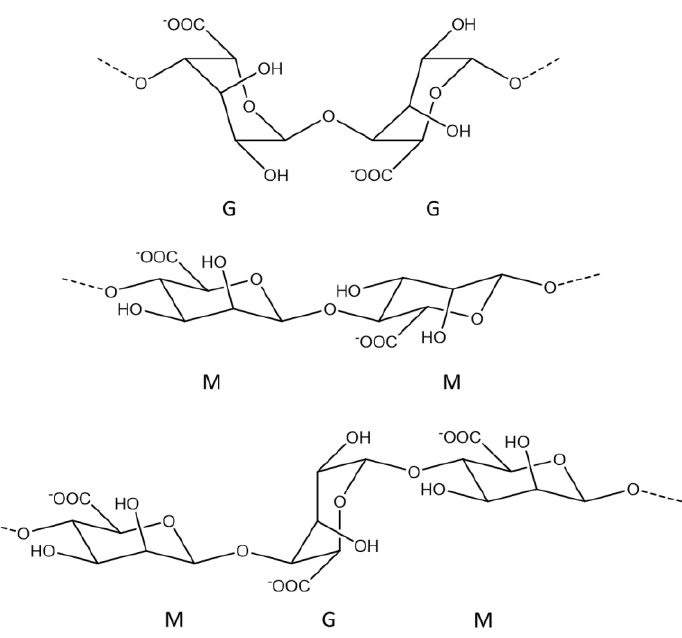
Figure 1. Chemical structure of G − block, M − block, and alternate block in alginates [2] .